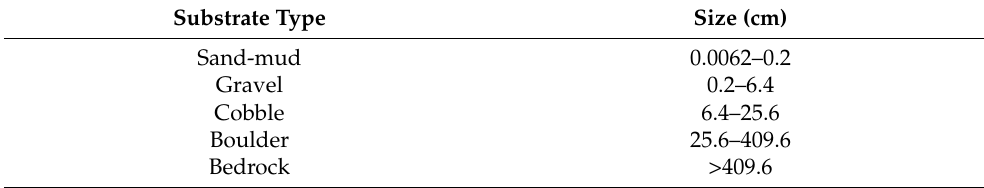
Table 1. Grid count data classification based on Wentworth scale